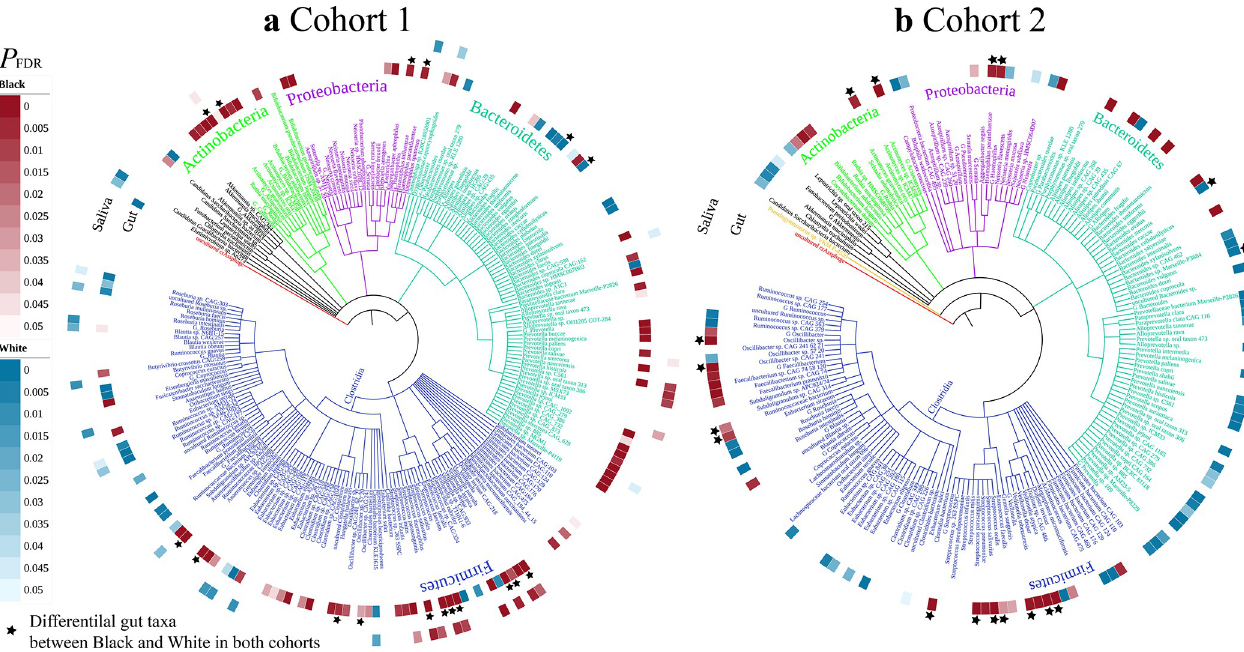
Fig 4. Ethnicity-associated variation in abundant microbial taxa and phage. The 219 taxa in cohort 1 (A) and 182 taxa in cohort 2 (B) included in the phylogeny are present in all participants and have relative abundances of > 1% in at least one of the gut or oral microbial metagenomes. The inner circle indicates differential taxa in the gut between the 2 ethnicities; the outer circle indicates differential taxa in the saliva between the 2 ethnicities. Pink or blue color gradients indicate FDR-adjusted p -value of significance (LinDA function in MicrobiomeStat package fitting linear mixed-effects models ‘~ Ethnicity + Antibiotic Use + Hormonal Contraceptive + (1|Day)’) for centered log-ratio transformed abundance between the 2 ethnicities. Data underlying this figure can be found at S1 Data. Pink indicates more abundant in Black participants, and blue indicates more abundant in White participants. Star indicates differential abundant taxa in the gut between the 2 ethnicities in both cohorts. Taxon name with a “G” before the name indicates the taxon was classified at the genus